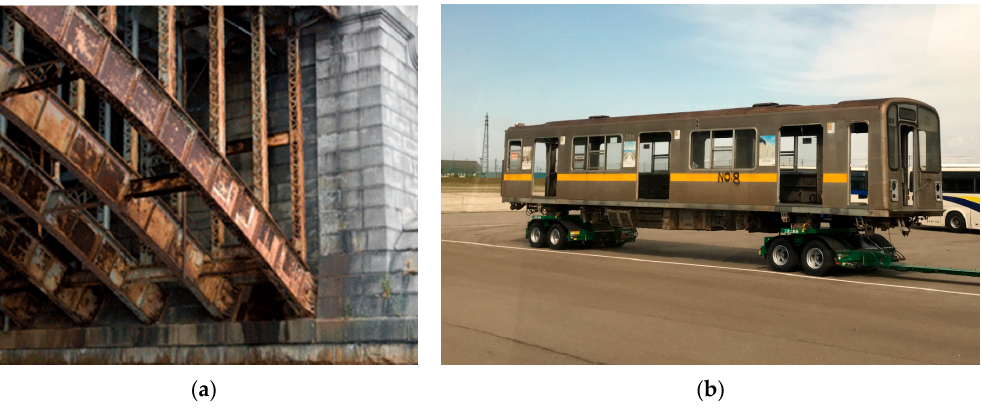
Figure 8. Corrosion of steel. ( a ) Extreme corrosion in a bridge. ( b ) Railway rolling stock being renovated.